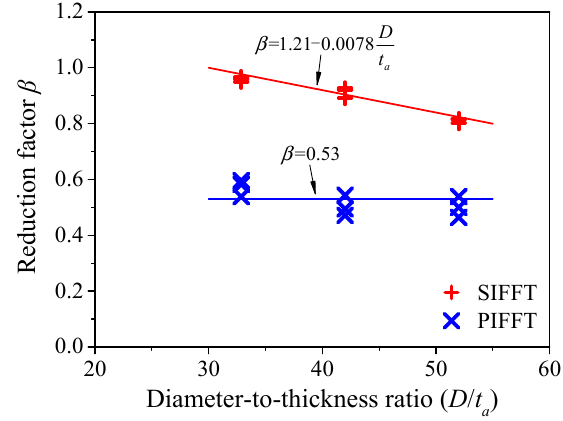
Figure 19. Relationship between β and D / t a in PIFFT and SIFFT specimens.